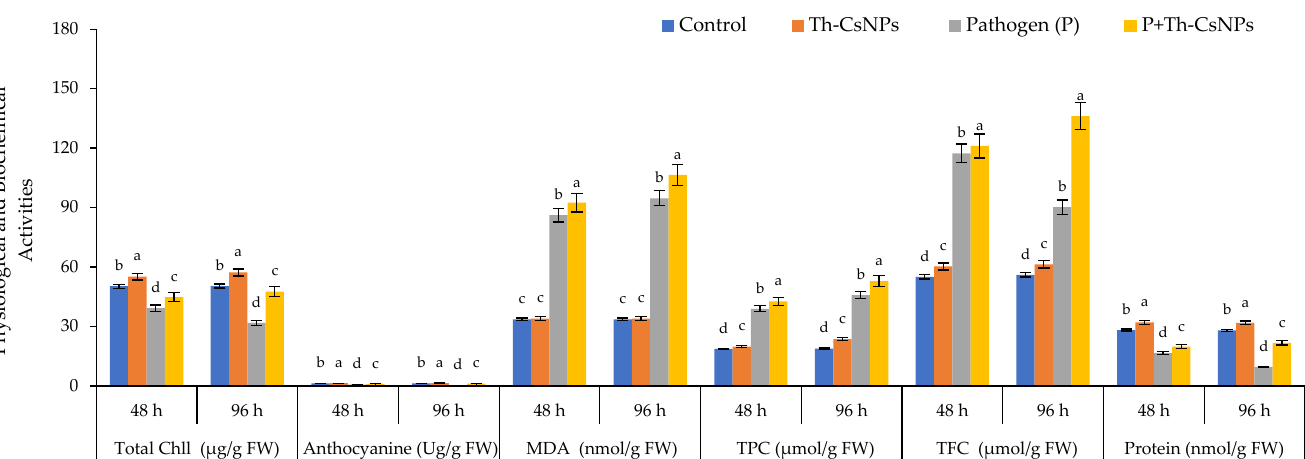
Figure 5. Effects of ThE-CsNPs on total chlorophyll, anthocyanin, MDA, TPC, TFC, and PC level in S. lycopersicum seedling under fusarium root rot disease infection. Bars with different letters indicate significant differences between treatments at p ≤ 0.05. Data are expressed as mean values of three replicates (±SDs).